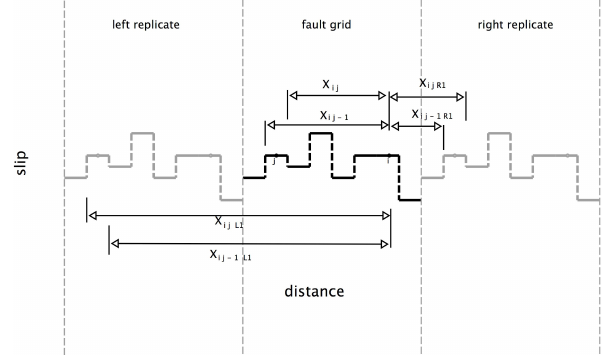
Fig. 3. Example grid, like Dieterich (1992) and Weertman (1979) but with periodic boundary conditions. This grid is used in all cal- culations in the present study. The periodic boundary conditions are used to approximate solutions obtained with an accurate Fourier method (Rubin and Ampuero,